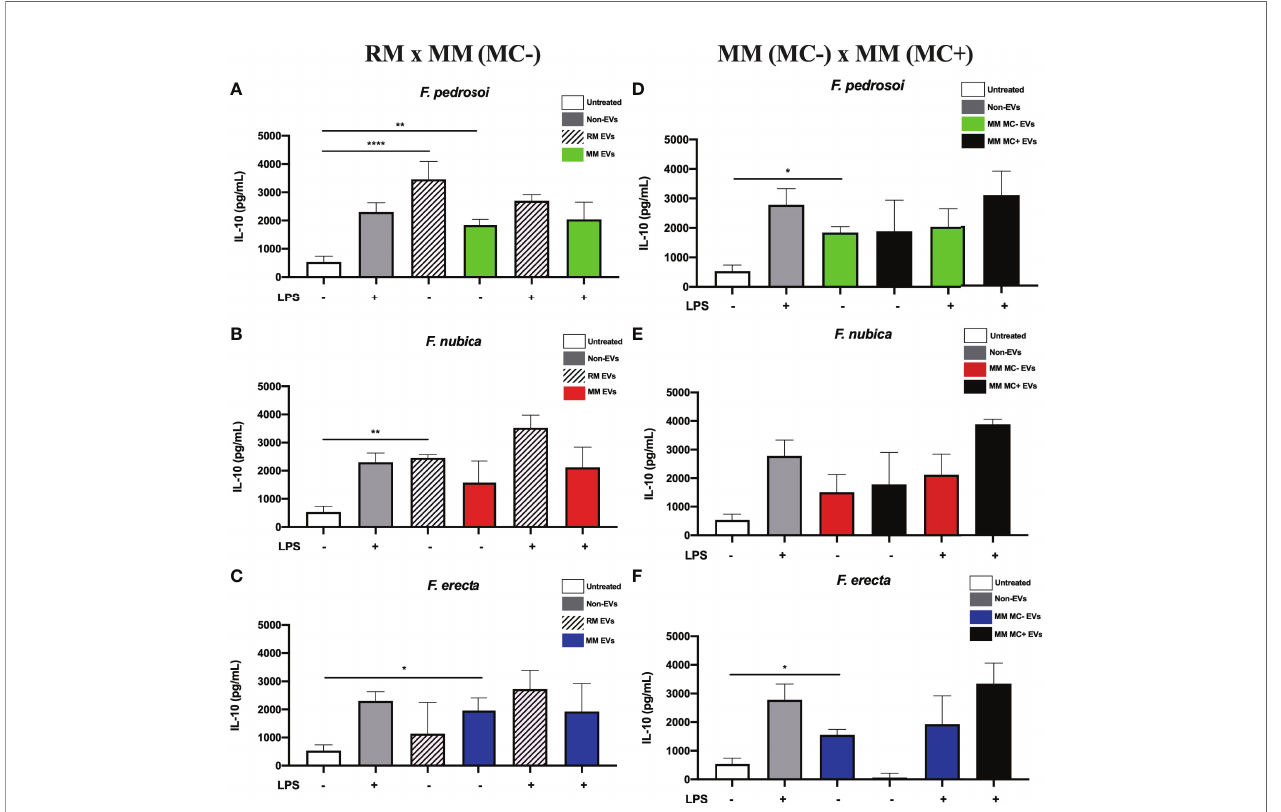
FIGURE 5 | EVs from F. pedrosoi and F. nubica isolated from the rich medium promote IL-10 production by bone-marrow-derived macrophages (BMDMs). MM MC- stands for minimum medium without muriform cells and MM MC+ for minimum medium in the presence of muriform cells. EVs (80 ng/mL of sterol content) from F. pedrosoi (A, D) , F. nubica (B, E) , and F. erecta (C, F) grown in RM, MM MC-, and MM MC+ were incubated with 1x10 6 BMDMs in the presence or absence of lipopolysaccharide (LPS, 500 ng/mL) for 24h. IL-10 production was quanti fi ed by enzyme-linked immunosorbent assay (ELISA). For all plots, * indicates p < 0.05, ** indicates p < 0.01, **** indicates p < 0.0001 compared to negative and positive controls according to one-way analysis of variance (ANOVA). The results presented in this work refer to a representative triplicate group experiment of at least two independent